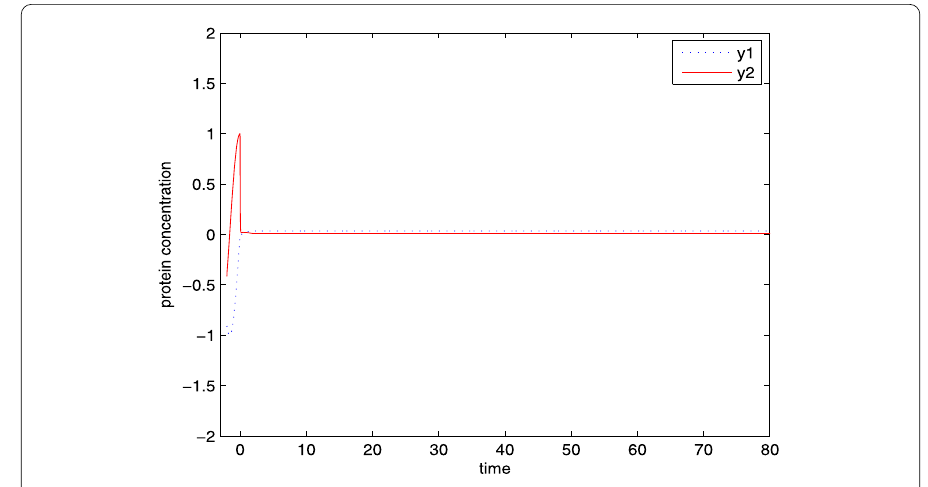
Figure 2 State responses of the protein concentration with impulsive